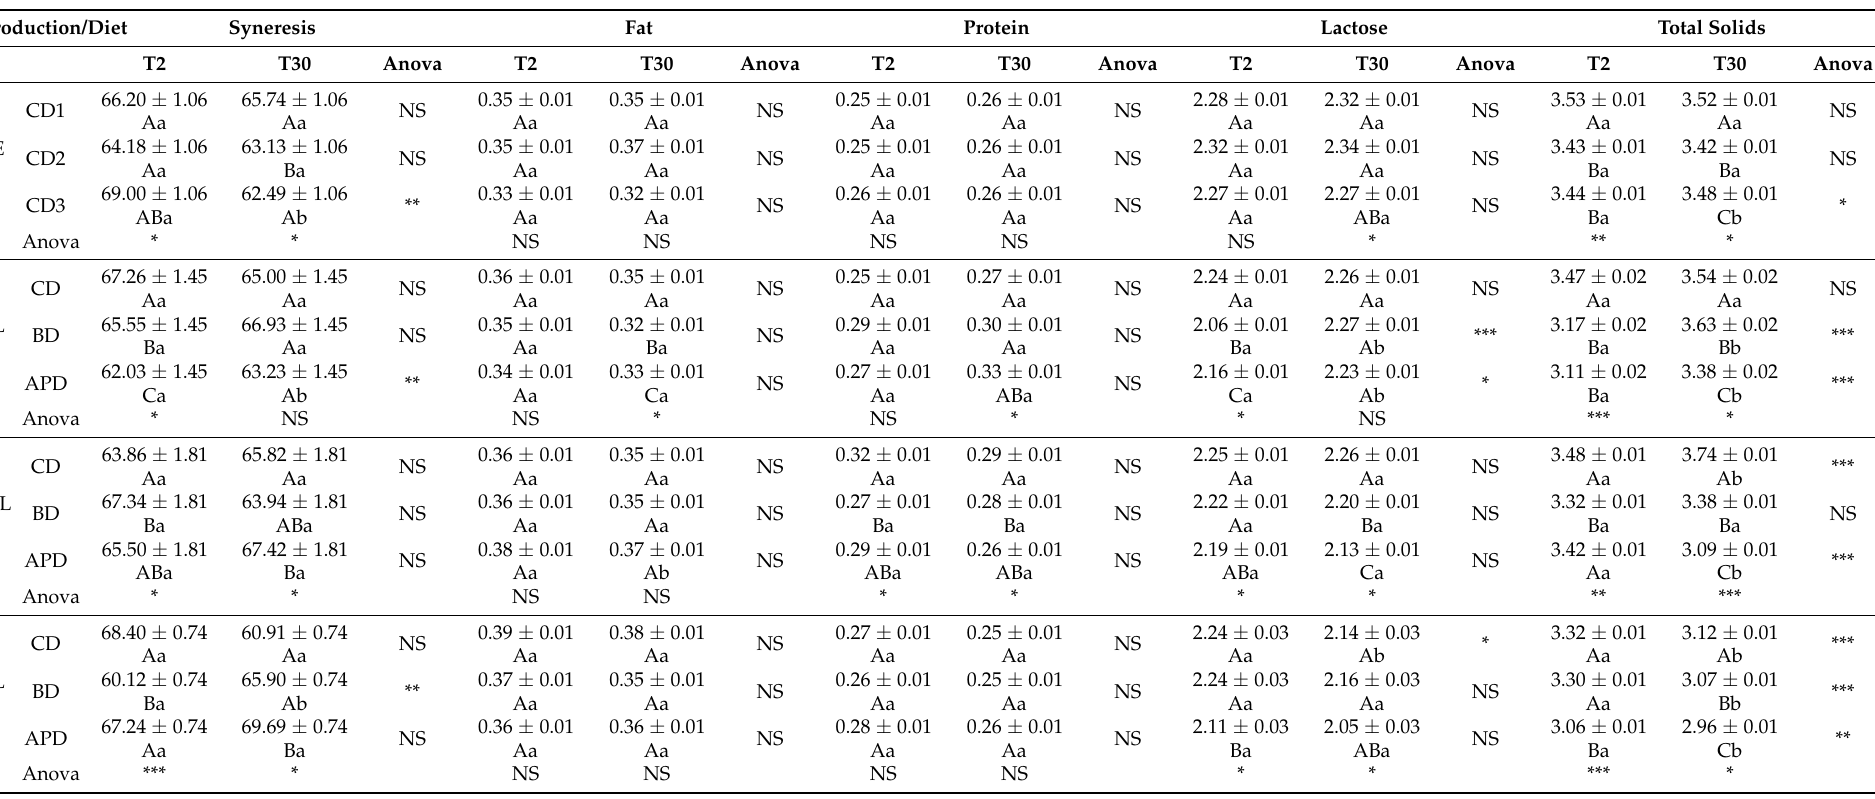
Table 6. Syneresis and main components (g/100 mL) of the expelled whey from fermented milk refrigerated at 4 ◦ C during 2 and 30 days using a thermophilic starter culture (YO-MIX TM